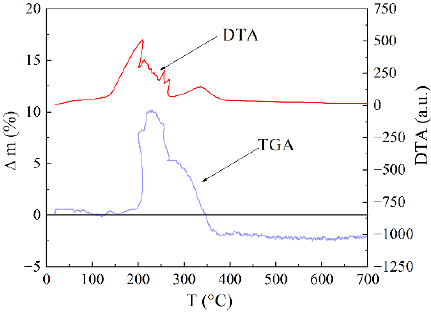
Figure 3. Result of TGA and differential thermal (DTA) study of Fe@C nanoparticles.